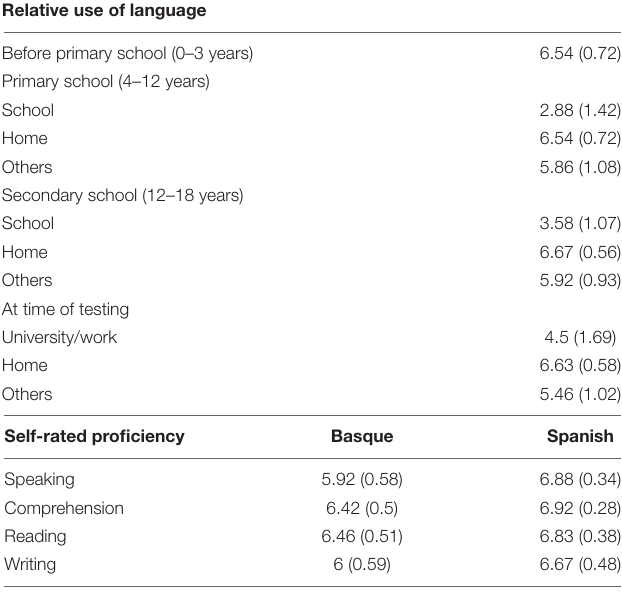
TABLE 1 | The following seven-point scale was applied for measuring the relative use of language: 1 = I speak only Basque, 2 = I speak mostly Basque, 3 = I speak Basque 75% of the time, 4 = I speak Basque and Spanish with similar frequency, 5 = I speak Spanish 75% of the time, 6 = I speak mostly Spanish, 7 = only Spanish.